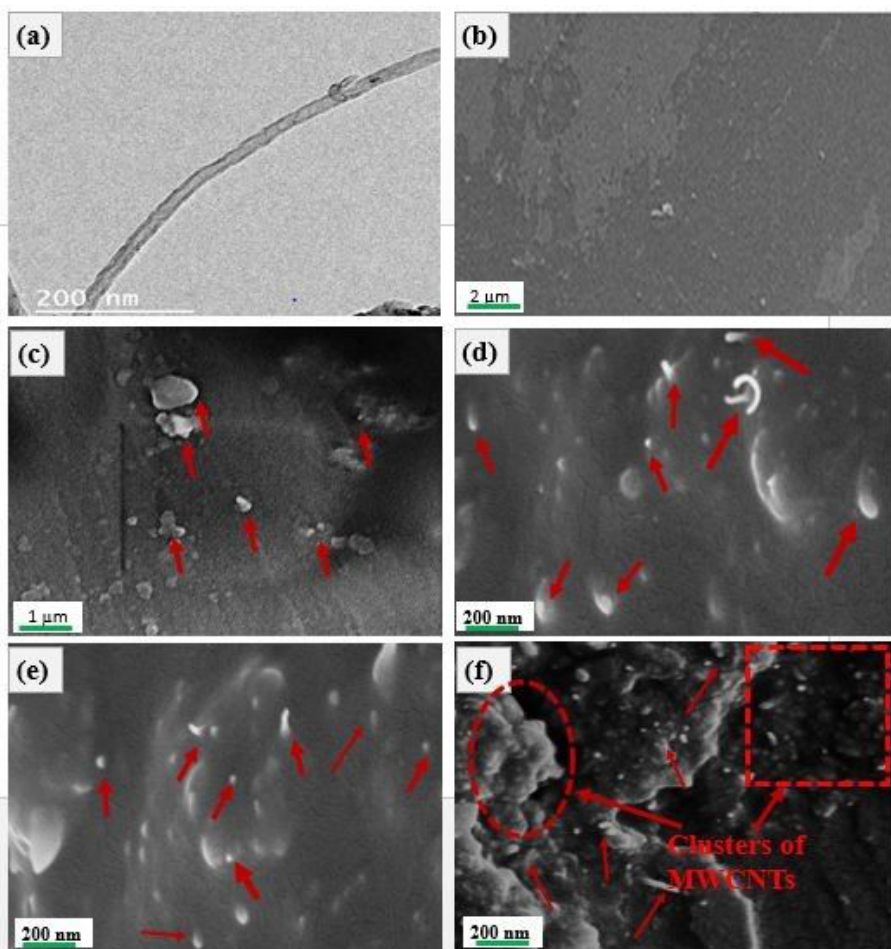
Figure 6: (a) TEM image of a MWCNT; and FESEM images of tensile fracture surface of (b) neat epoxy, (c) epoxy nanocomposite with 0.25 wt.% of MWCNTs, (d & e) epoxy nanocomposite with 0.5 wt.% of MWCNTs (f) epoxy nanocomposite with 1.0 wt.% of MWCNTs